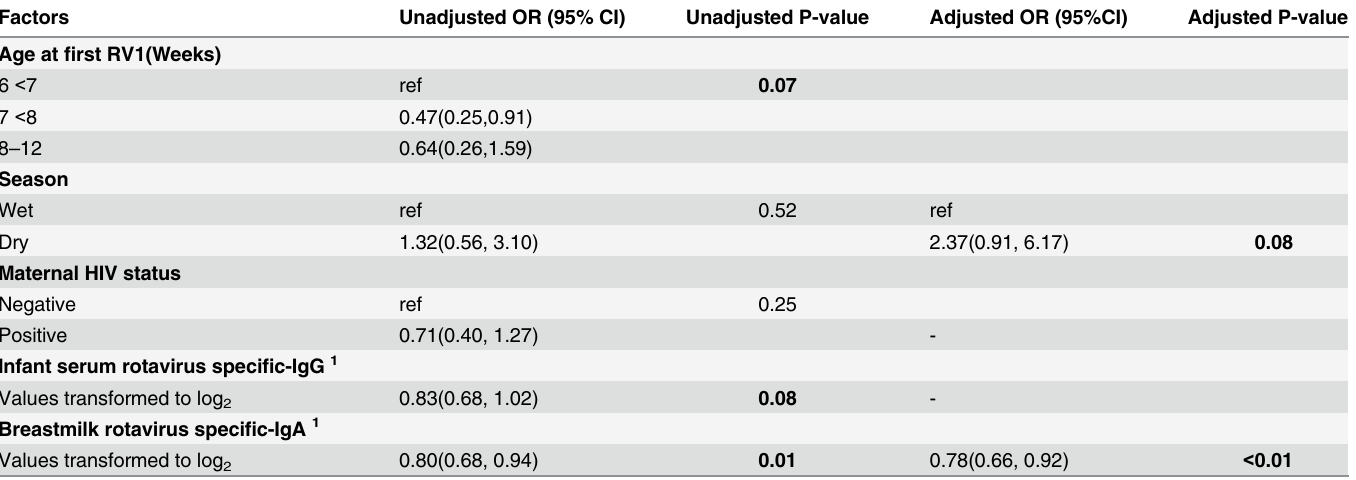
Table 2. Maternal and infant factors independently associated with odds of seroconversion (N = 210).